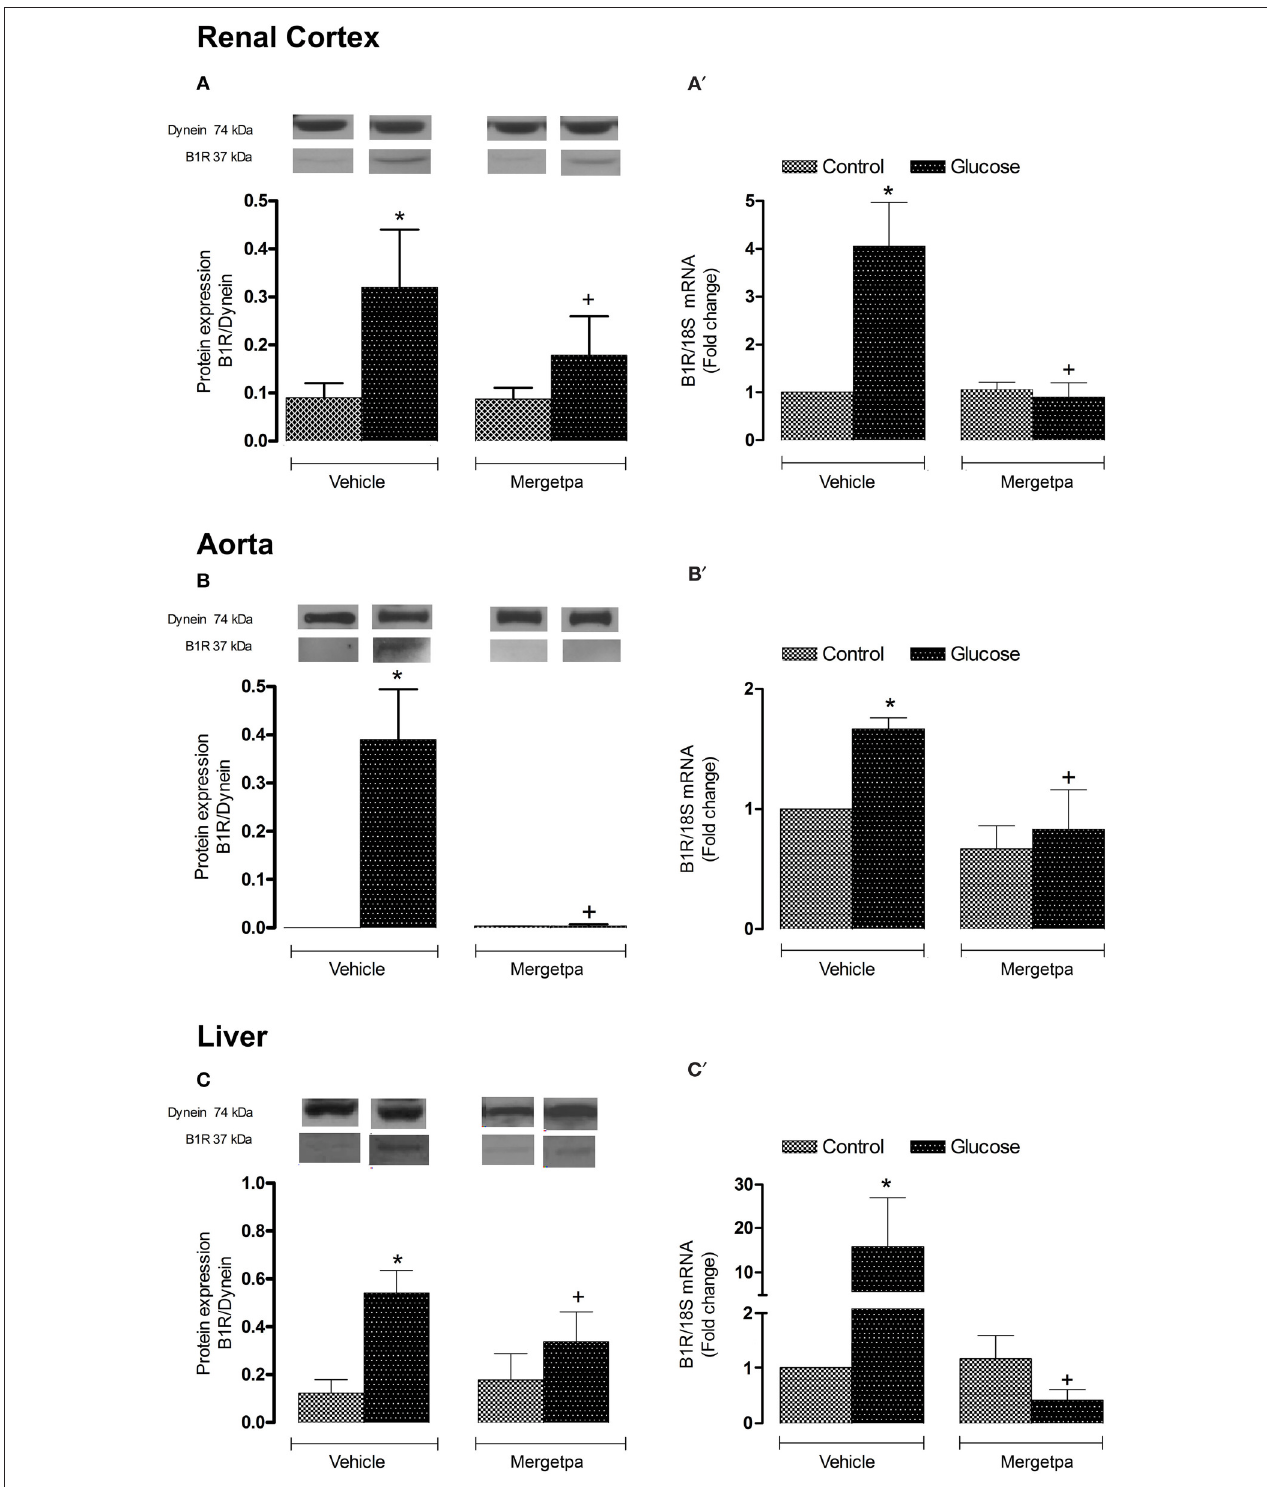
FIGURE 4 | Treatment effect on B1R expression. Effect of s.c. administered Mergetpa (1 mg.kg − 1 twice daily) for 7 days on B1R expression in (A,A’) renal cortex, (B,B’) thoracic aorta and (C,C’) liver. The expression of B1R was measured at the protein level by western blot (A–C) and at mRNA level by qRT-PCR (A’,B’,C’) . Dynein was the loading control. Data are mean ± SEM obtained from six rats per group. * P < 0.05 compared with control + vehicle; + P < 0.05 compared with glucose + vehicle. Data in vehicle treated rats are from a previous study (Haddad and Couture, 2016) but performed simultaneously.